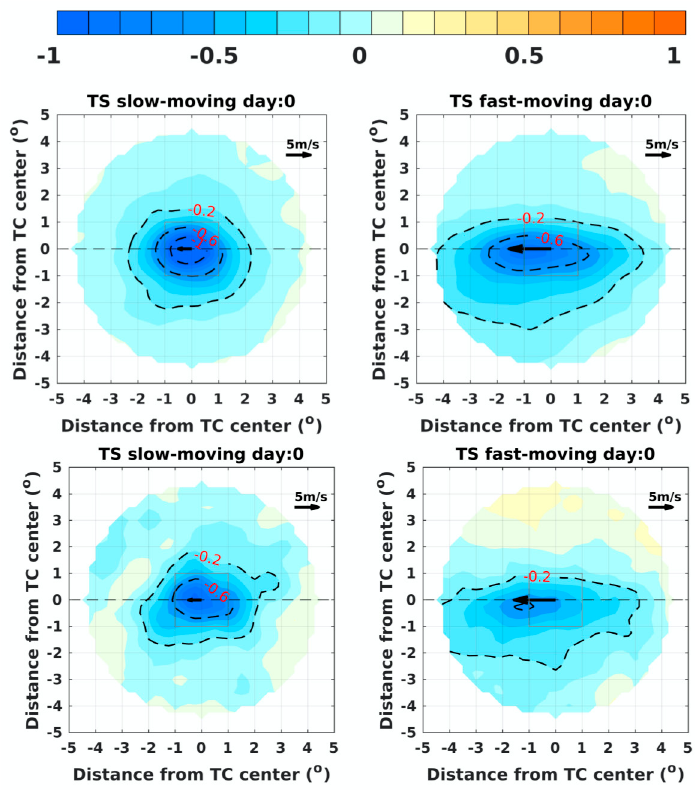
Figure 11. Distribution of SSS response (psu) to tropical storms on day 0 in the Northern Hemisphere based on translation speed, with SMAP (upper panels) and SMOS (lower panels) swath daily data. Same time period from March 2015 to December 2019 is used for both SMAP and SMOS satellite data. The mean translation speed is 2.48 and 7.80 m s − 1 , respectively.